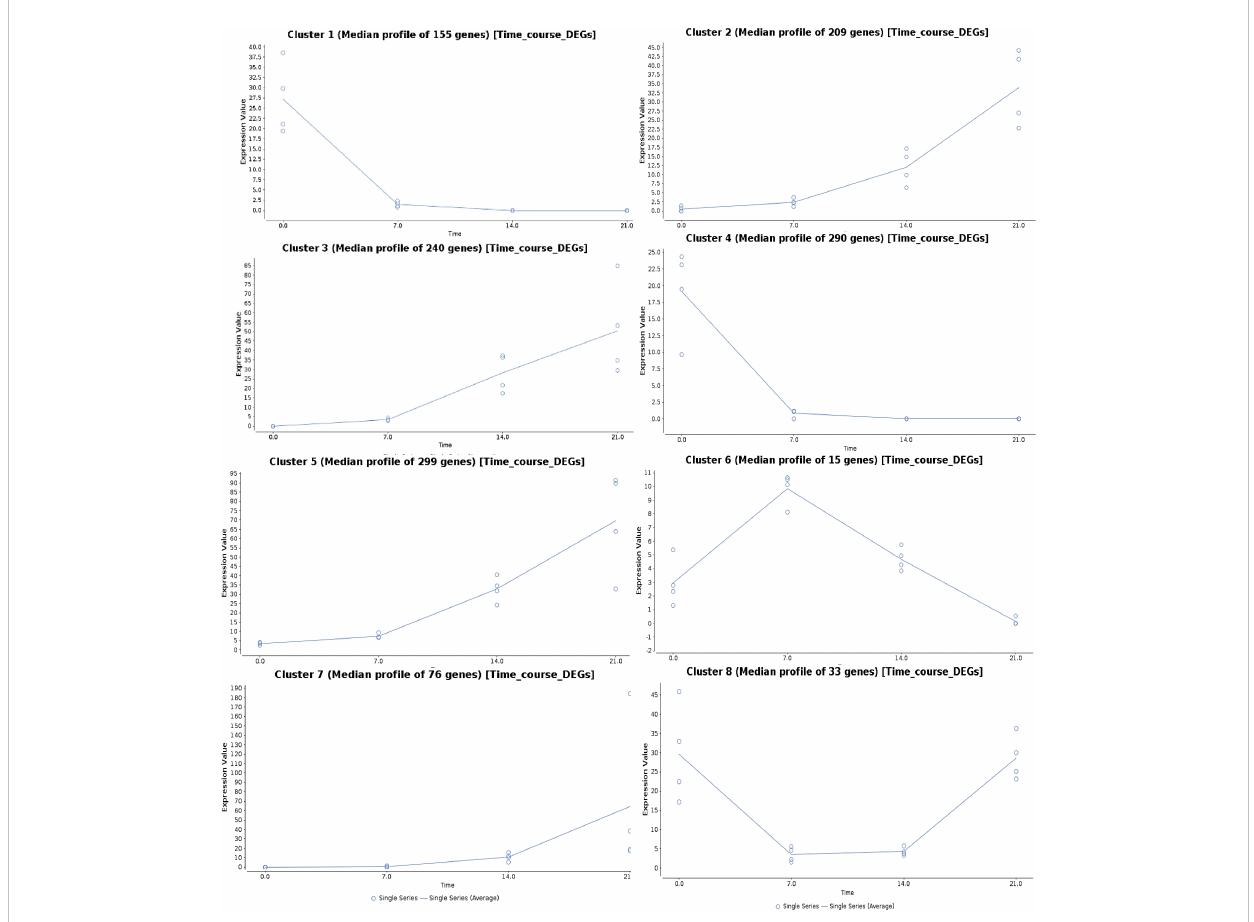
FIGURE 5 Time-series gene expression analysis showing the expression pattern in eight different clusters upon different drought stress periods in sugar